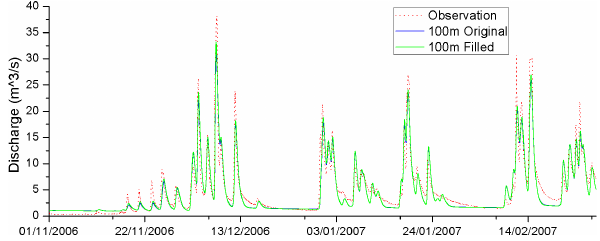
Fig. 13. Whole catchment flow simulations using 100m resolution DEM in MIKE SHE.